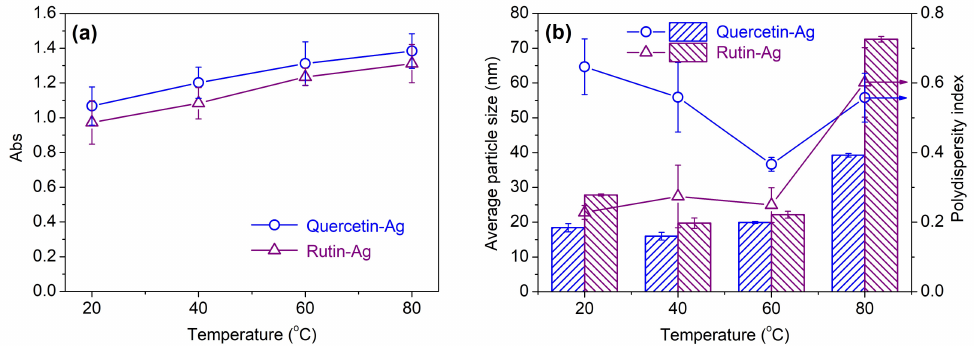
Figure 4. Absorbance ( a ) and average particle size ( b ) of the biosynthesized AgNPs at various